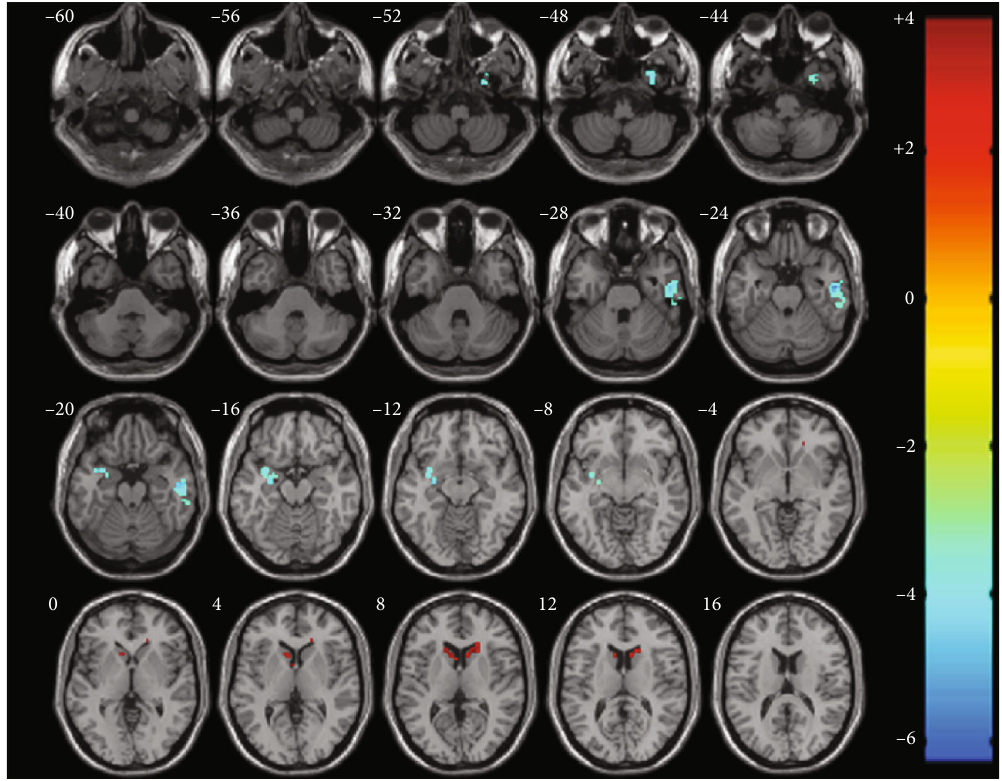
Figure 2: Brain regions showing altered connectivity to the right hippocampus in the aMCI group comparing to HC at baseline. Numbers in the fi gure indicate the Z coordinate in MNI space. The color scale represents t values. Warm color represents increased connectivity; cold color represents decreased